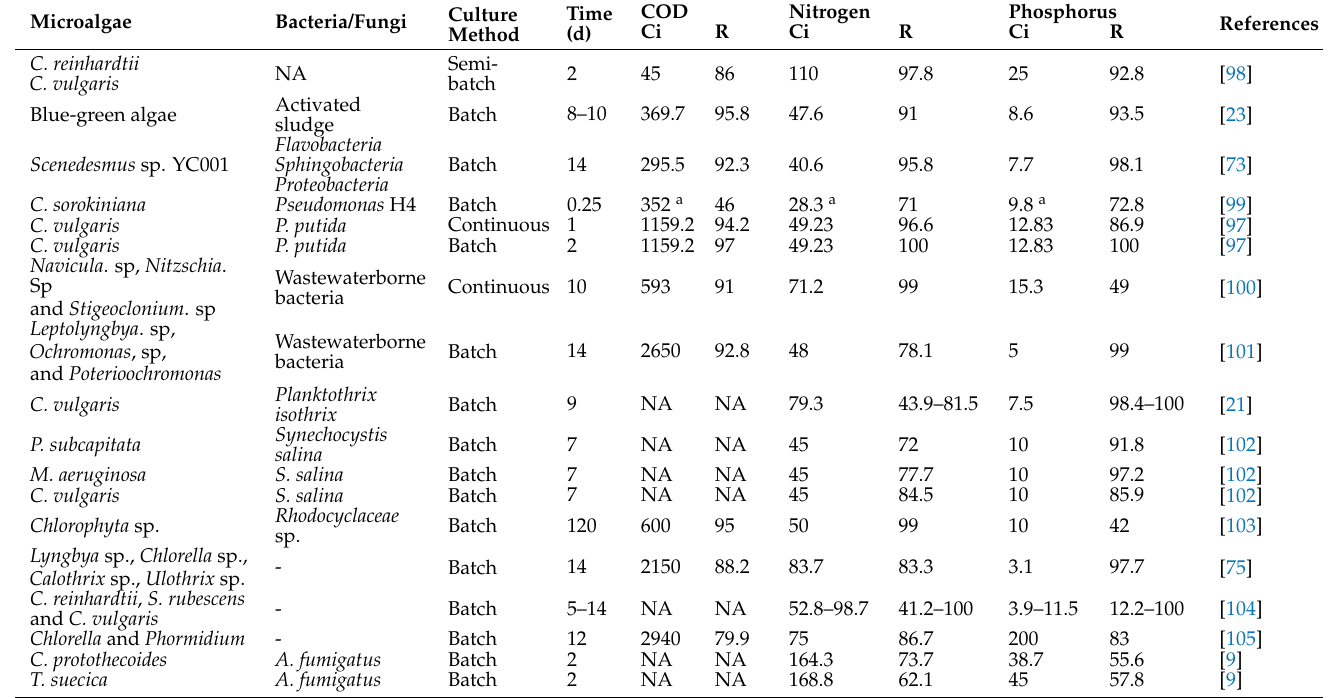
Table 4. Nutrient removal efficiency of microalgal consortia in wastewater treatment.